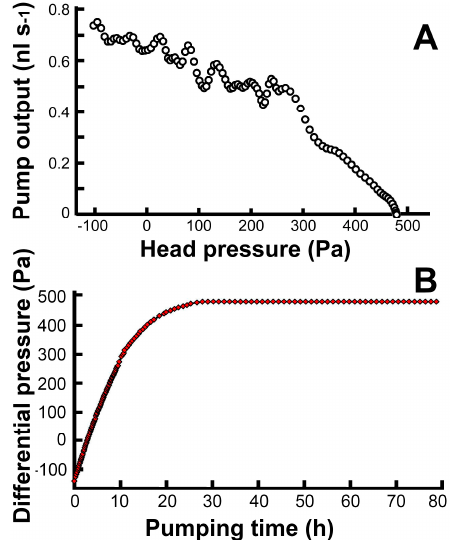
Figure 4. The relation between the volumetric pump output and the pump head pressure ( A ); the head pressure is the measured differential pressure ( B ) between the input channel and the output channel of the pump.